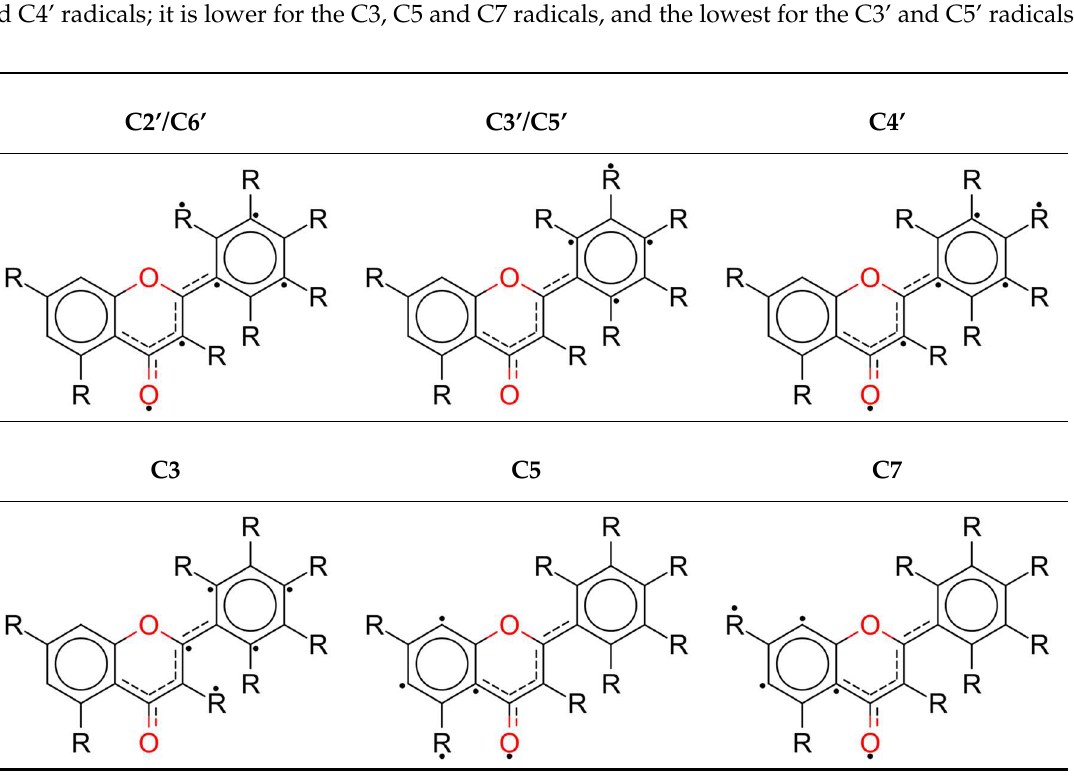
Figure 1. Lewis structures of radicals with the biggest electron densities of atoms marked with a